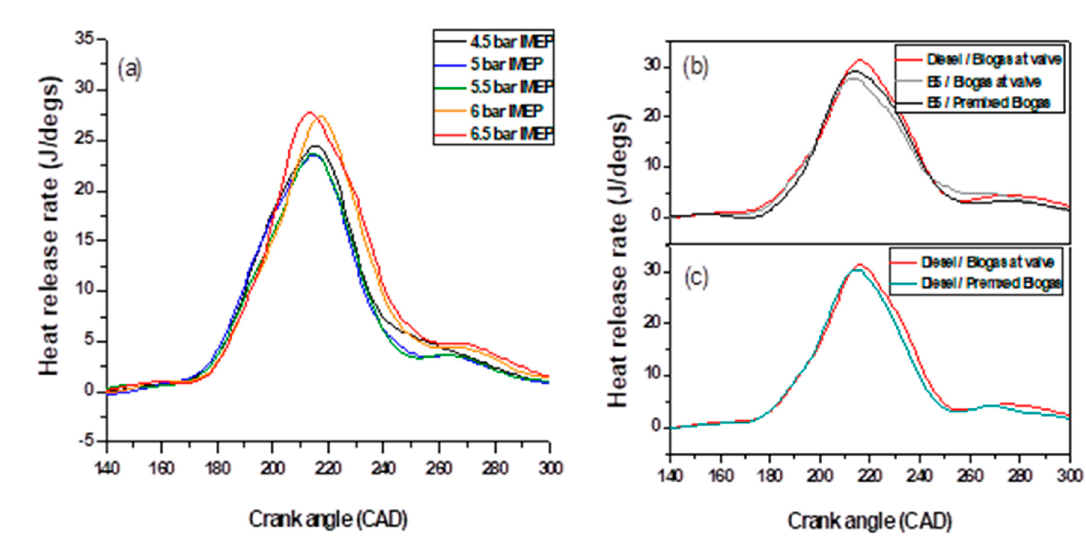
Figure 7. The heat release rate for the ( a ) combustion of B5/biogas injected at a valve for various load capacities, ( b ) B5/biogas RCCI in premixed and injection at a valve for 6.5 bar IMEP, and ( c ) diesel/biogas in a premixed and port injection at the valve for 6.5 bar IMEP.